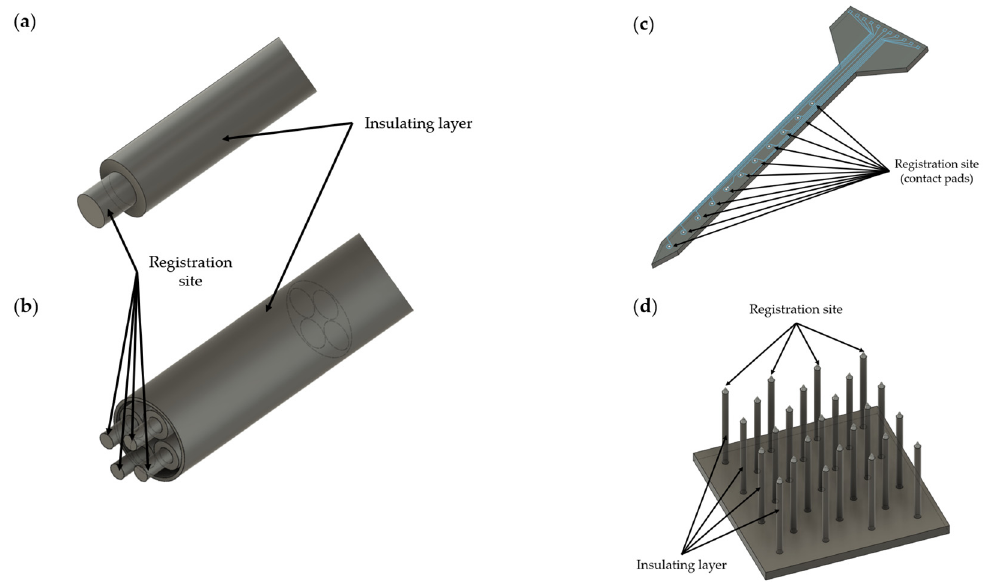
Figure 1. Schematic representation of different types of microelectrodes: ( a ) single-microwire neural electrode; ( b ) tetrode; ( c ) planar (Michigan) microelectrode; ( d ) Utah array.